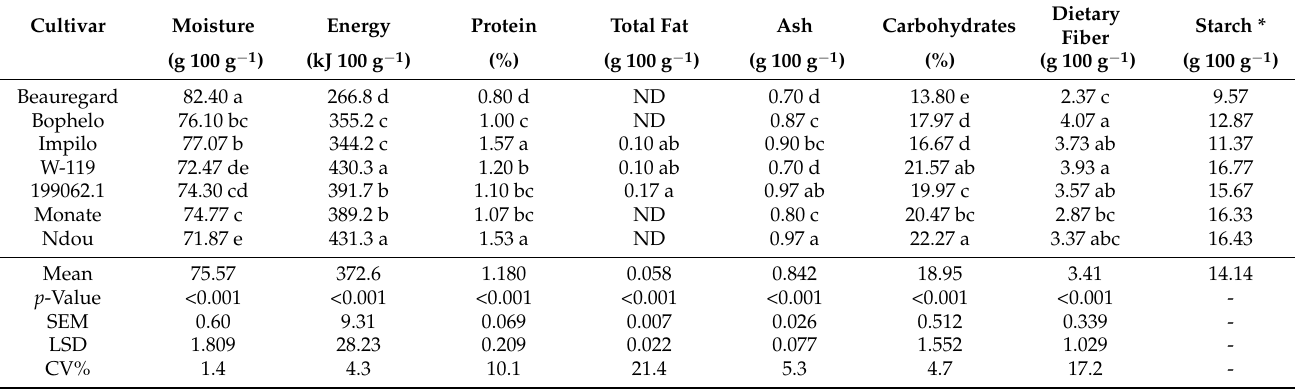
Table 1. Composite analysis (fresh weight basis) of sweet potato cultivars with varying flesh colors. Cultivar